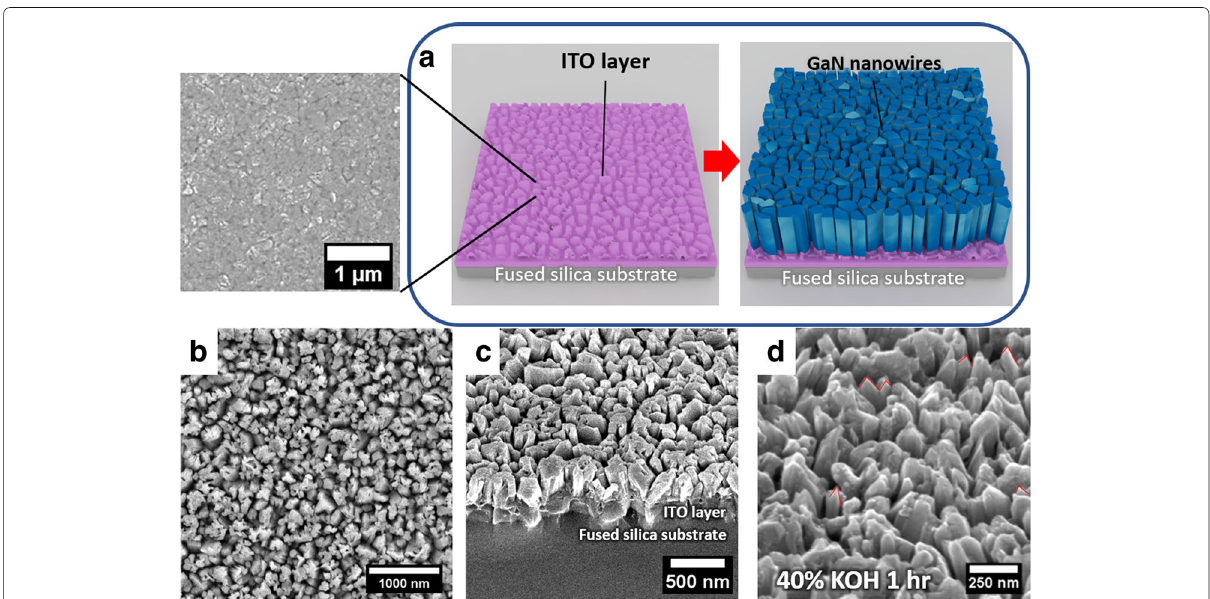
Fig. 2 a Schematic illustrating the growth of GaN nanowires on rough ITO surface. The inset shows an SEM plan view of the rough ITO surface after thermal annealing. b Plan view of GaN nanowires grown on ITO. c Elevation view of GaN nanowires grown on ITO. d Elevation view of